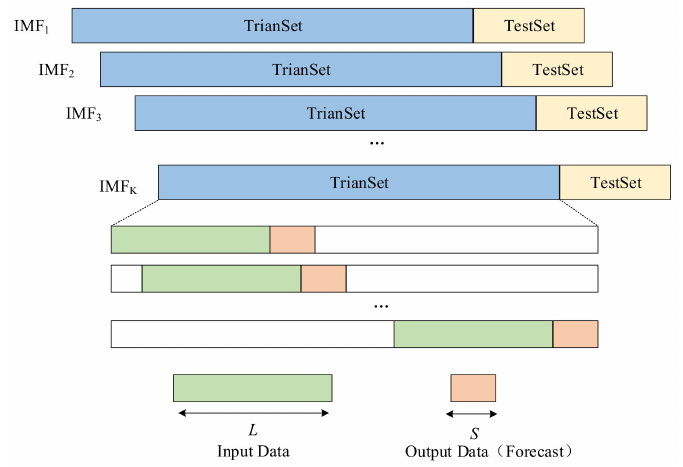
Figure 6. Moving window procedure that obtains the input–output